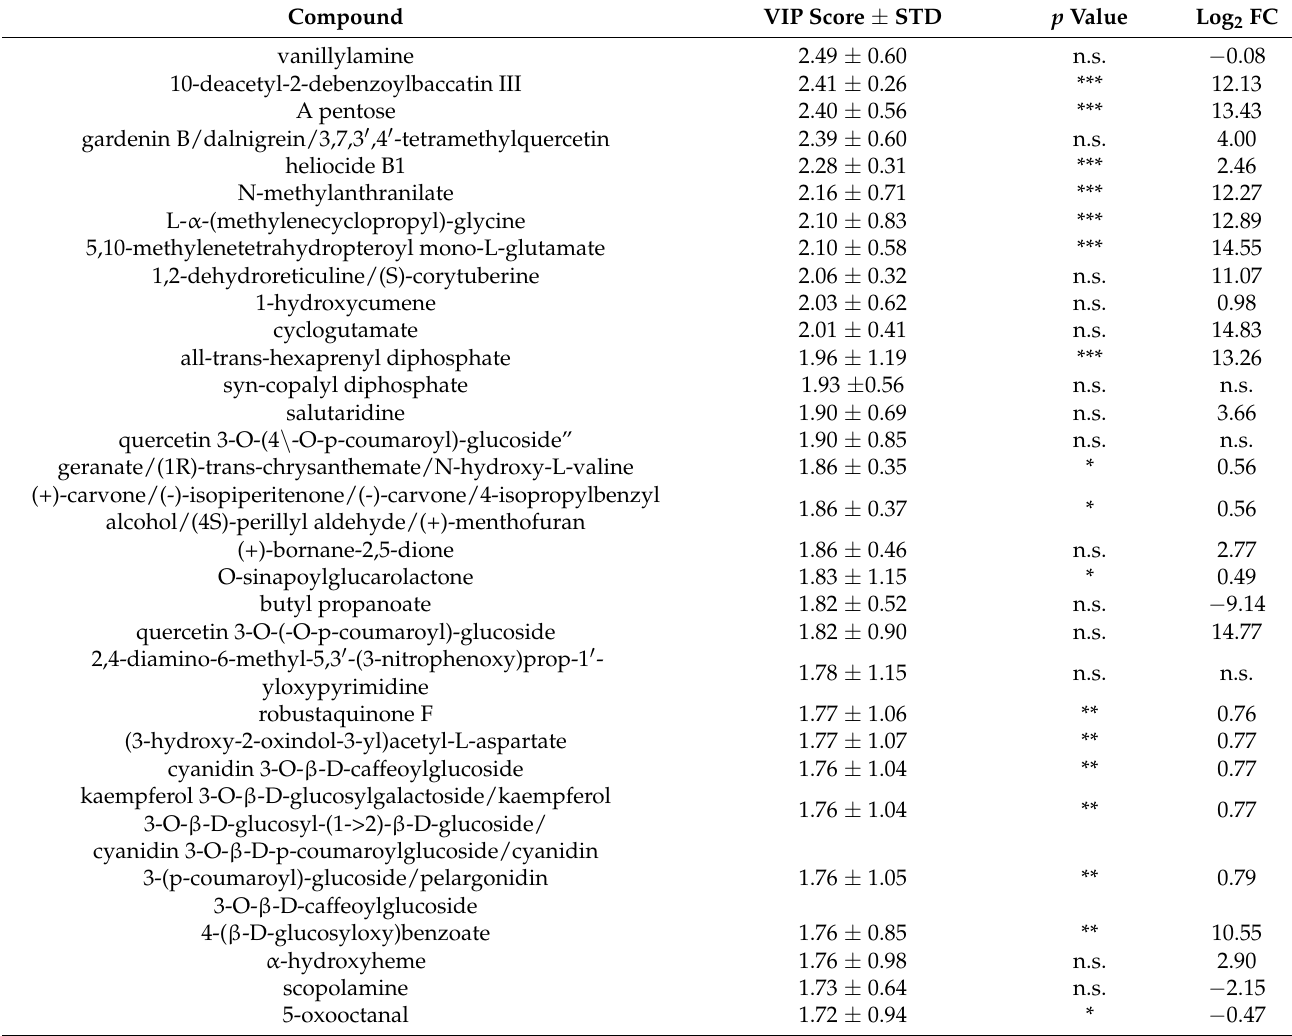
Table 2. Root metabolic markers, according to their VIP score ± standard deviation (STD), related to the OPLS-DA model in Figure 2c (effect of UV treatment). Compounds are provided with p value and their Log 2 FC calculated in respect to control samples. * p ≤ 0.05, ** p < 0.01, *** p < 0.001, n.s., not